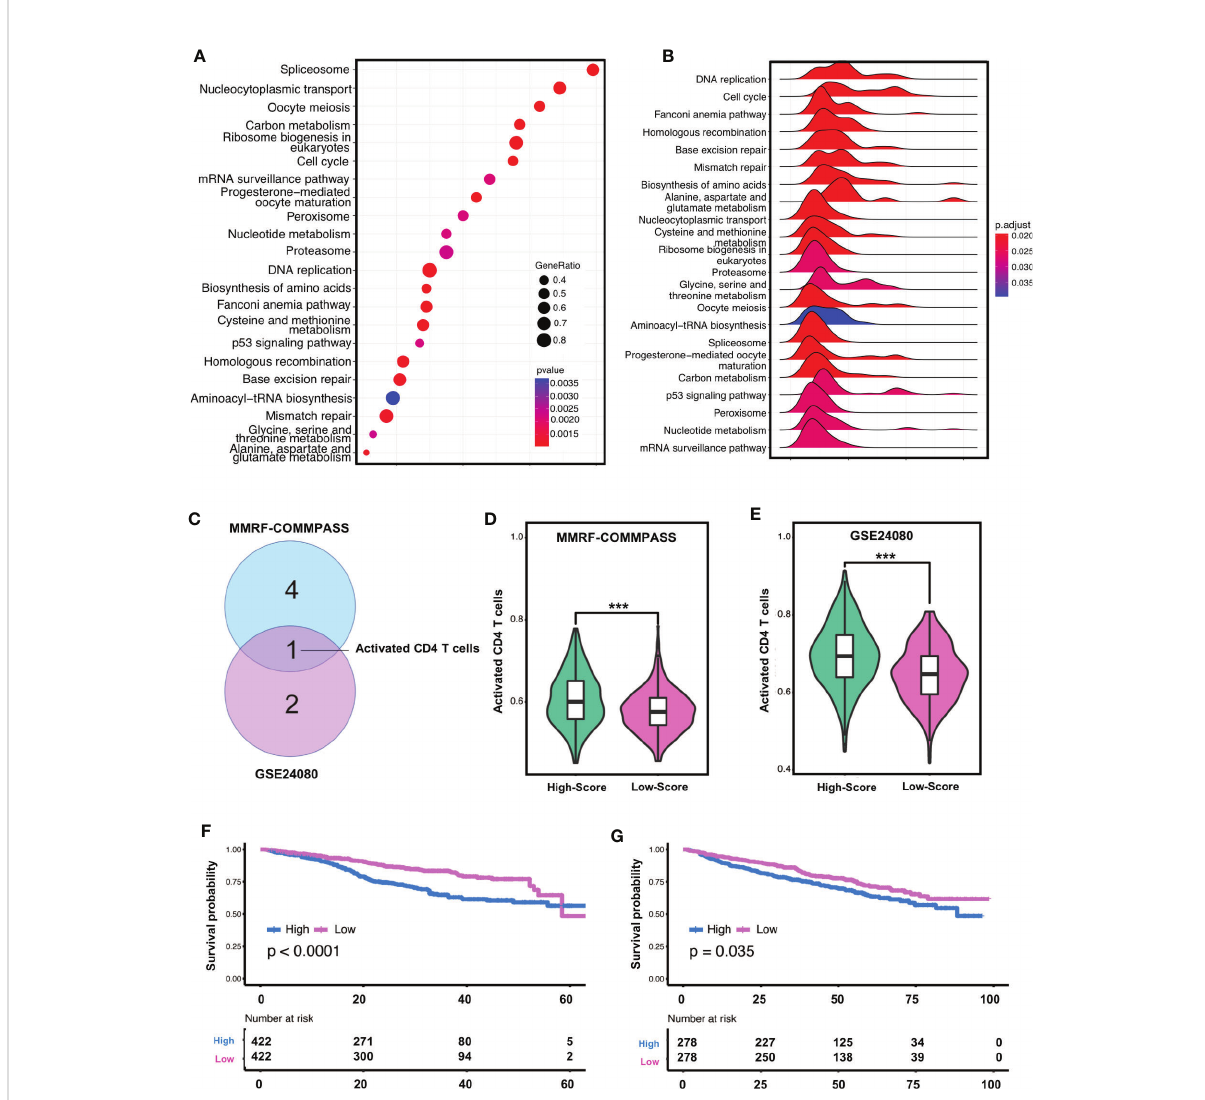
FIGURE 2 Gene enrichment and immuno fi ltration analysis con fi rmed the relevance of the signature in high-risk MM patients. (A) Bubble diagram shows gene counts and gene ratio of the signi fi cantly enriched KEGG pathway terms. (B) Ridgeline plot shows enrichment score of the signi fi cantly enriched KEGG pathway terms. (C) Immune cell population alternation associated with OS with statistically signi fi cant difference in both cohorts. (D, E) the enrichment degree of high-risk group was signi fi cantly higher than that of low-risk group in both cohorts by ssGSEA analyses *** indicates P-value < 0.001. (F, G) Activated CD4+T cells were relevant to survival in both the training cohorts. KEGG, kyoto encyclopedia of genes and genomes; GSEA, gene set enrichment analysis; ES, enrichment